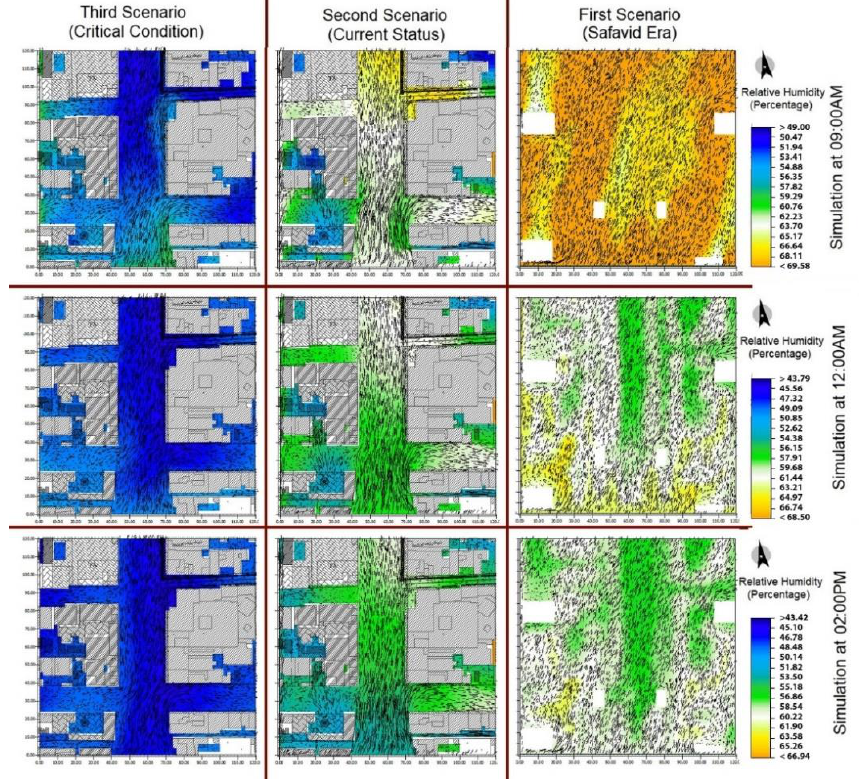
Figure 7. Comparison of relative humidity in the three scenarios during different hours of the day.